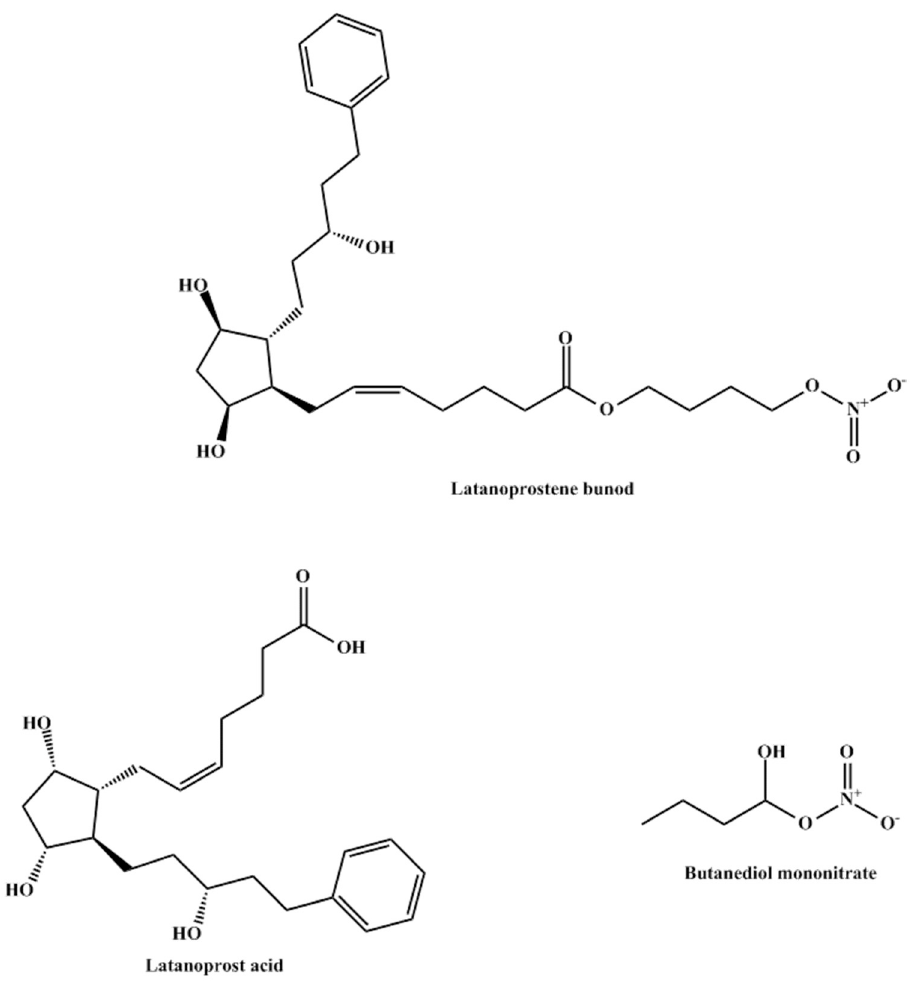
Figure 6. Structures of latanoprostene bunod, latanoprost acid, and butanediol mononitrate.